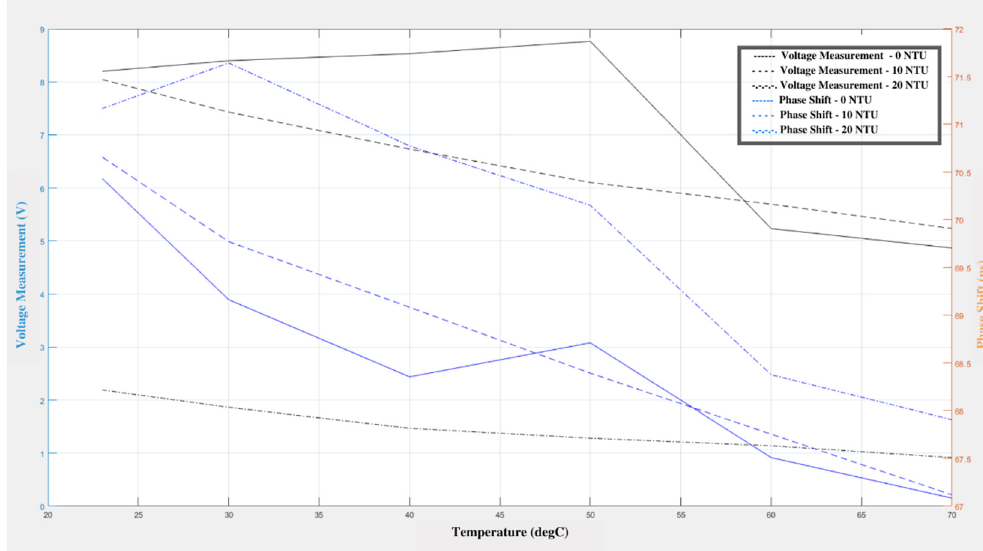
Figure 3. Variation in voltage and phase shift in relation to changes in the turbidity and temperature of the water.